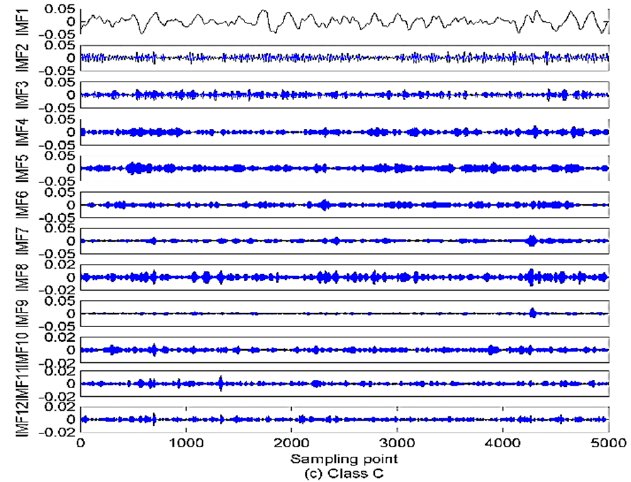
Figure 14. The EVMD results for SRN signals. ( a ) Class A signal; ( b ) Class B signal; ( c ) Class C signal.